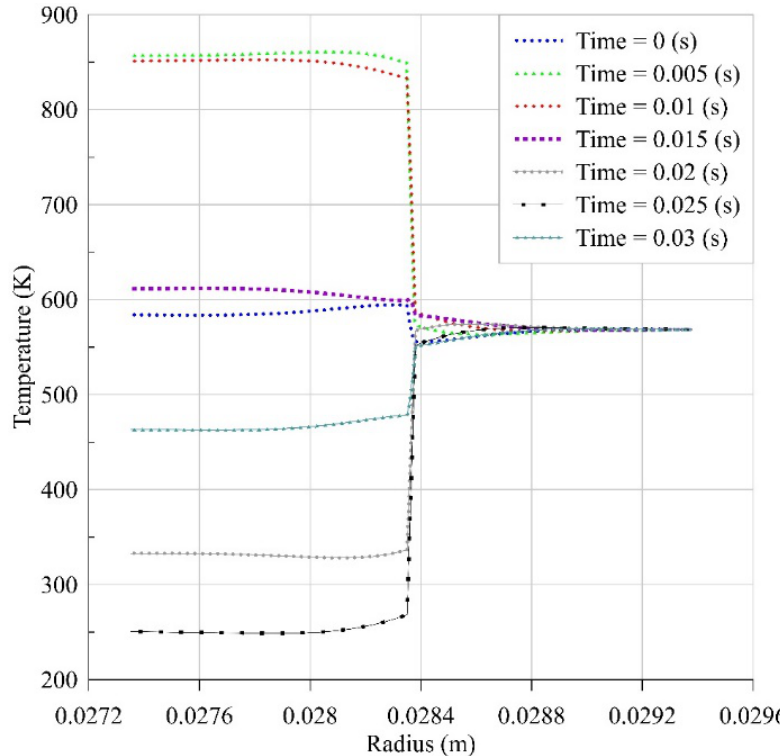
Figure 9. Flow temperatures in the gap = 30 μm.